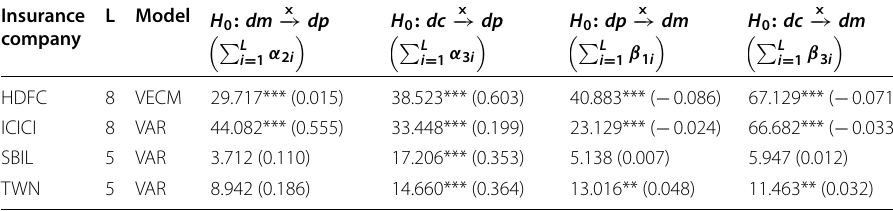
We use the Akaike information criterion (AIC) statistic to select the optimal Lag periods (L) and the Wald chi‑square statistic to test the causality between variables. The notation "***" and "**" represent 1% and 5% significance levels, respectively; L represents the Lag periods